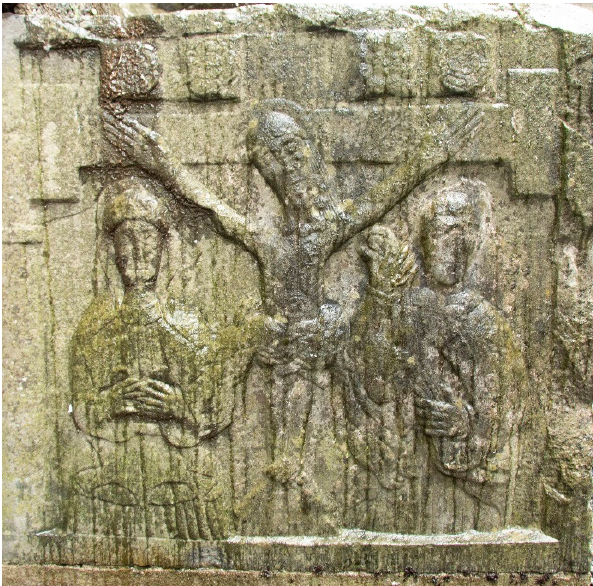
Figure 21. Purcell Tomb in St John’s Priory, Co. Kilkenny, sixteenth century. Photograph by the